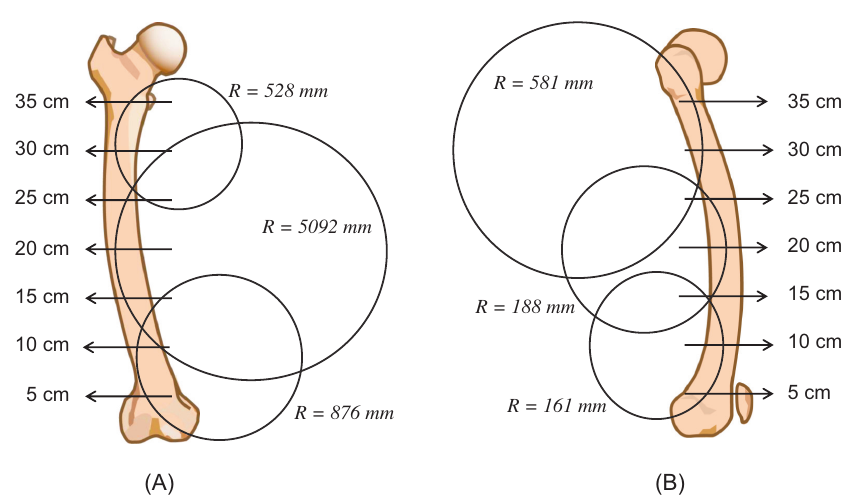
Figure 3. (A) Segmental radii of curvature in the coronal plane of the femur, showing that the Japanese femur is more laterally bowed in proximal, followed by distal and to a much less degree the middle part, (B) segmental radii of curvature in the sagittal plane of the femur, showing that the Japanese femur is more anteroposteriorly bowed in distal, followed by middle and lastly the proximal part.